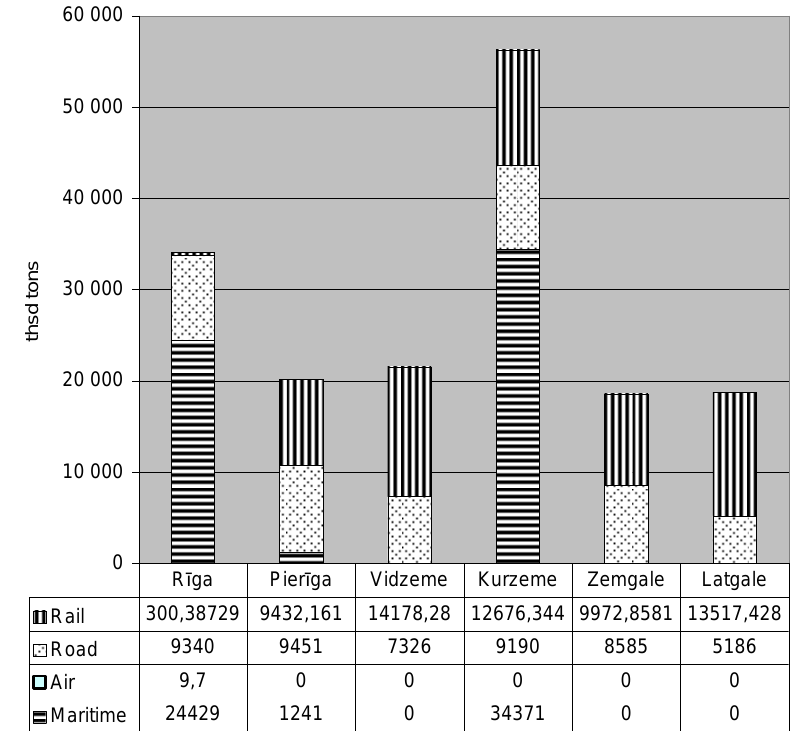
Fig 5. Distribution of cargo flow by modes of transport in the regions of Latvia in 2005